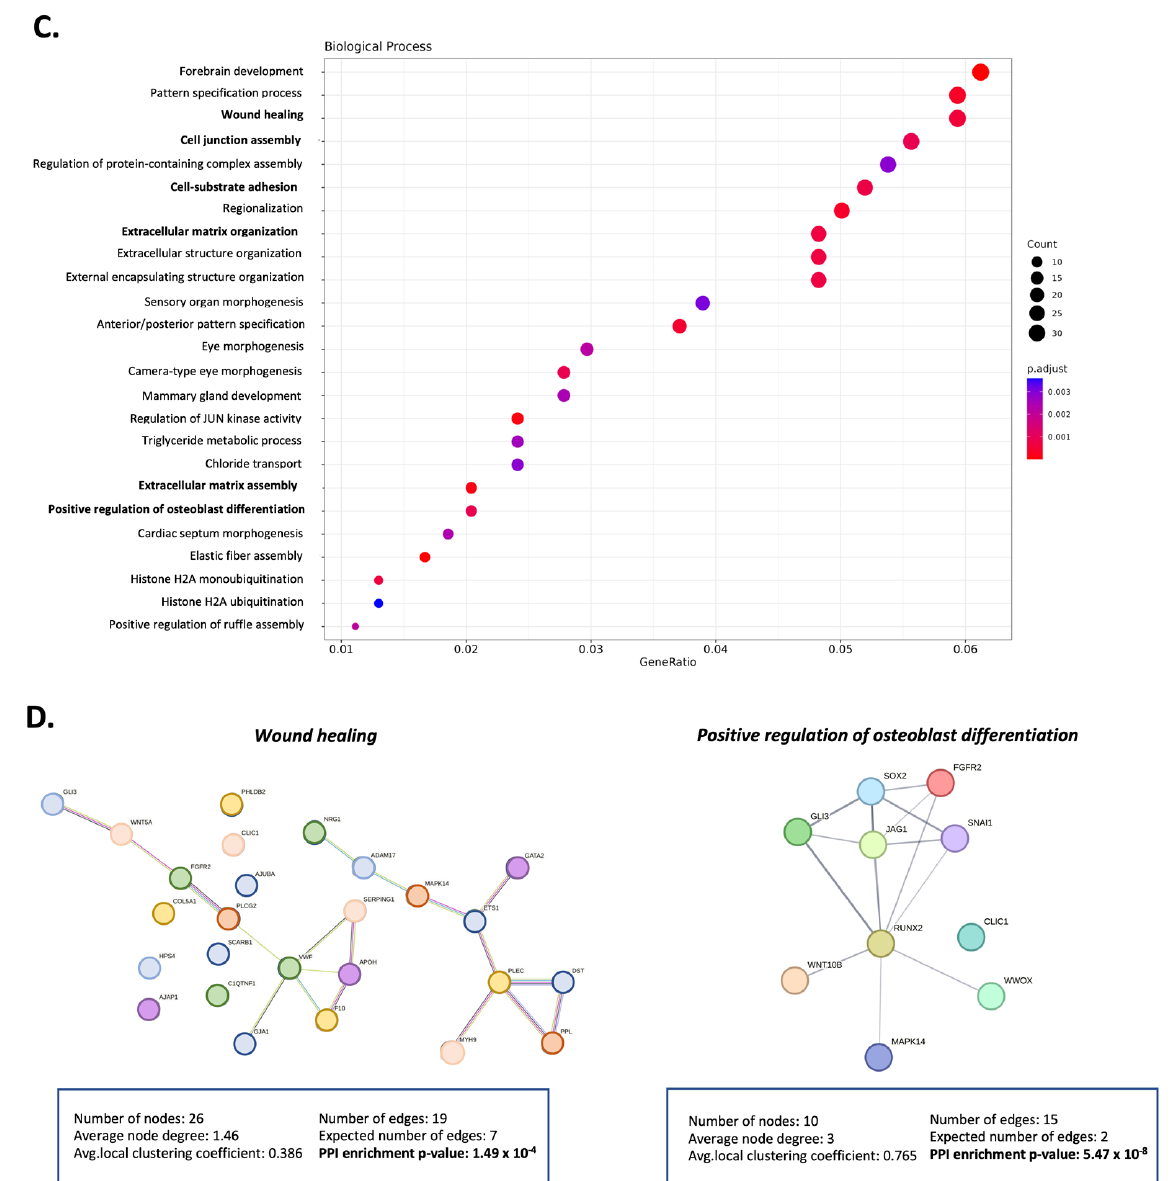
Figure 2. Exploratory data analysis of the differentially methylated positions in adipose-derived stem cells isolated from patients with Crohn’s disease and healthy controls. ( A ) Heat map showing the correlation data between the nine main components and clinical parameters such as body mass index (BMI), Crohn’s disease or smoking habit. Each cell of the heatmap shows the Pearson correlation coefficient. Asterisks indicate significant correlation (* p < 0.05; ** p < 0.01). ( B ) Principal component (PC) analysis demonstrating the first two principal components of the overall DNA methylation profiles, showing a discernible differentiation between patients with Crohn’s disease who are smokers (blue triangles), non-smokers (green triangles) or ex-smokers (orange triangles). Also, healthy controls are represented with a circle. ( C ) Gene ontology enrichment analysis of the biological processes using the whole set of genes with significant differentially methylated positions (DMPs). Different color scale represents the p -adjusted values and the size of the circles represents the number of genes implicated in each process. ( D ) Functional analysis of gene-associated DMPs in Crohn’s disease. Left. Gene–gene interaction involving 26 genes implicated in wound healing and which are differentially methylated in smoker, non-smoker and ex-smoker patients with Crohn’s disease. Right. Gene–gene interaction involving 10 genes implicated in positive regulation of osteoblast differentiation and